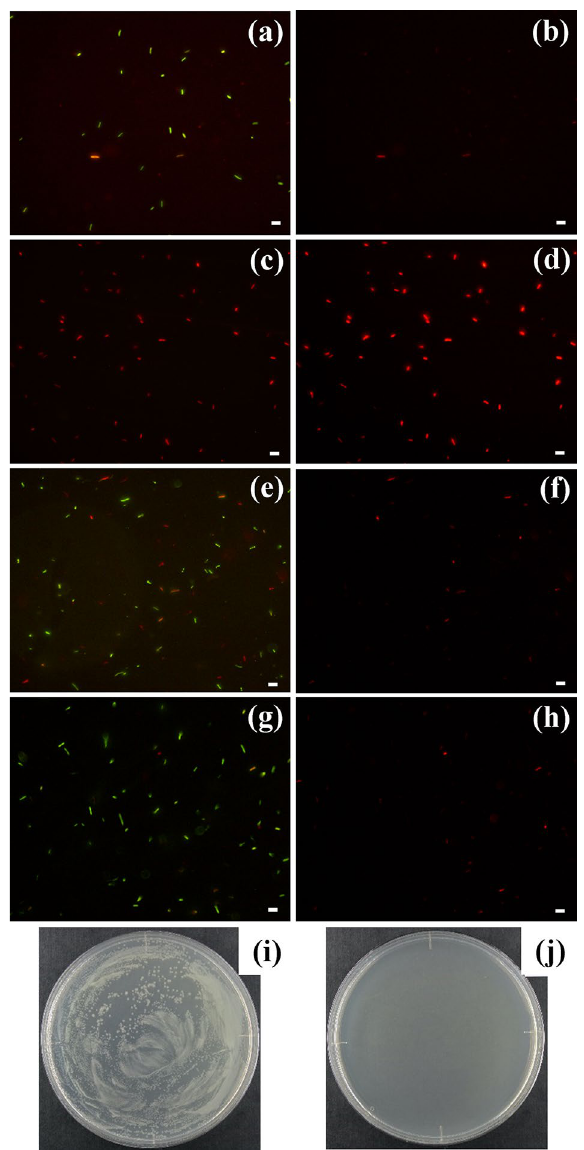
Figure 6. Living or dead states of E. coli determined from Live/Dead assay with fluorescence microscopy measurements (10 μm scale bar). ( a ) Green and red, and ( b ) only red fluorescence images before pulsed laser irradiation, and ( c ) green and red, and ( d ) only red fluorescence images after pulsed laser irradiation (420 nm and 180 kJ/cm 2 ). ( e ) Green and red, and ( f ) only red fluorescence images before DUV irradiation, and ( g ) green and red, and ( h ) only red fluorescence images after DUV irradiation (λ = 265 nm and doseage = 60 mJ/ cm 2 ). Images ( a ), ( c ), ( e ), and ( g ) show fluorescence emitted from both thiazole orange and propidium iodide and images ( b ), ( d ), ( f ), and ( h ) show fluorescence emitted from only propidium iodide. Photographs of CFU- evaluations ( i ) before and ( j ) after DUV irradiation are shown to compare with the fluorescence images ( e – h